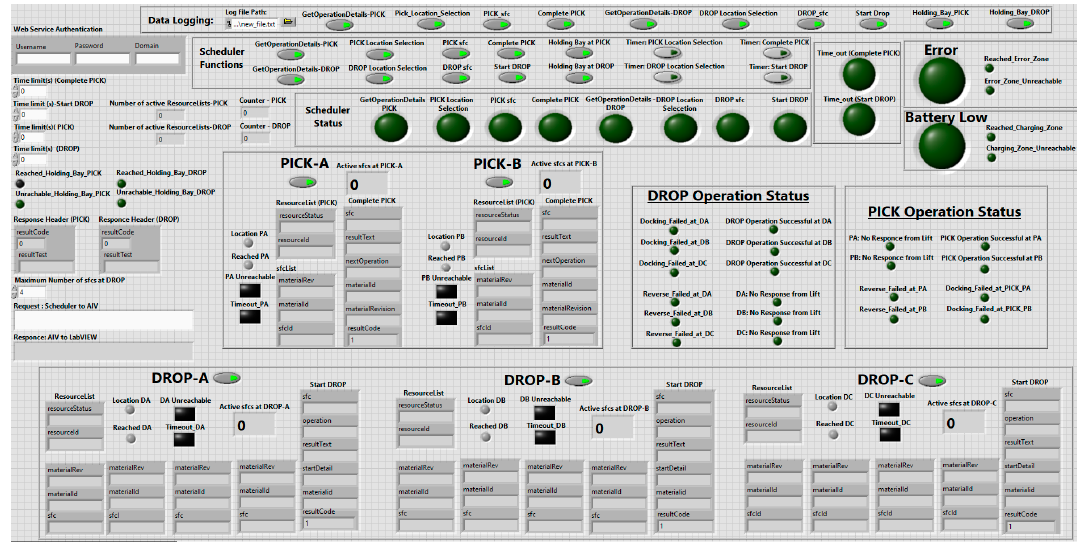
Figure 19. Testing setup. Here, the coordinates of single pickup location are used for two pickup locations and similarly scheduler is tested for three drop ‐ off locations by using coordinates of single drop ‐ off